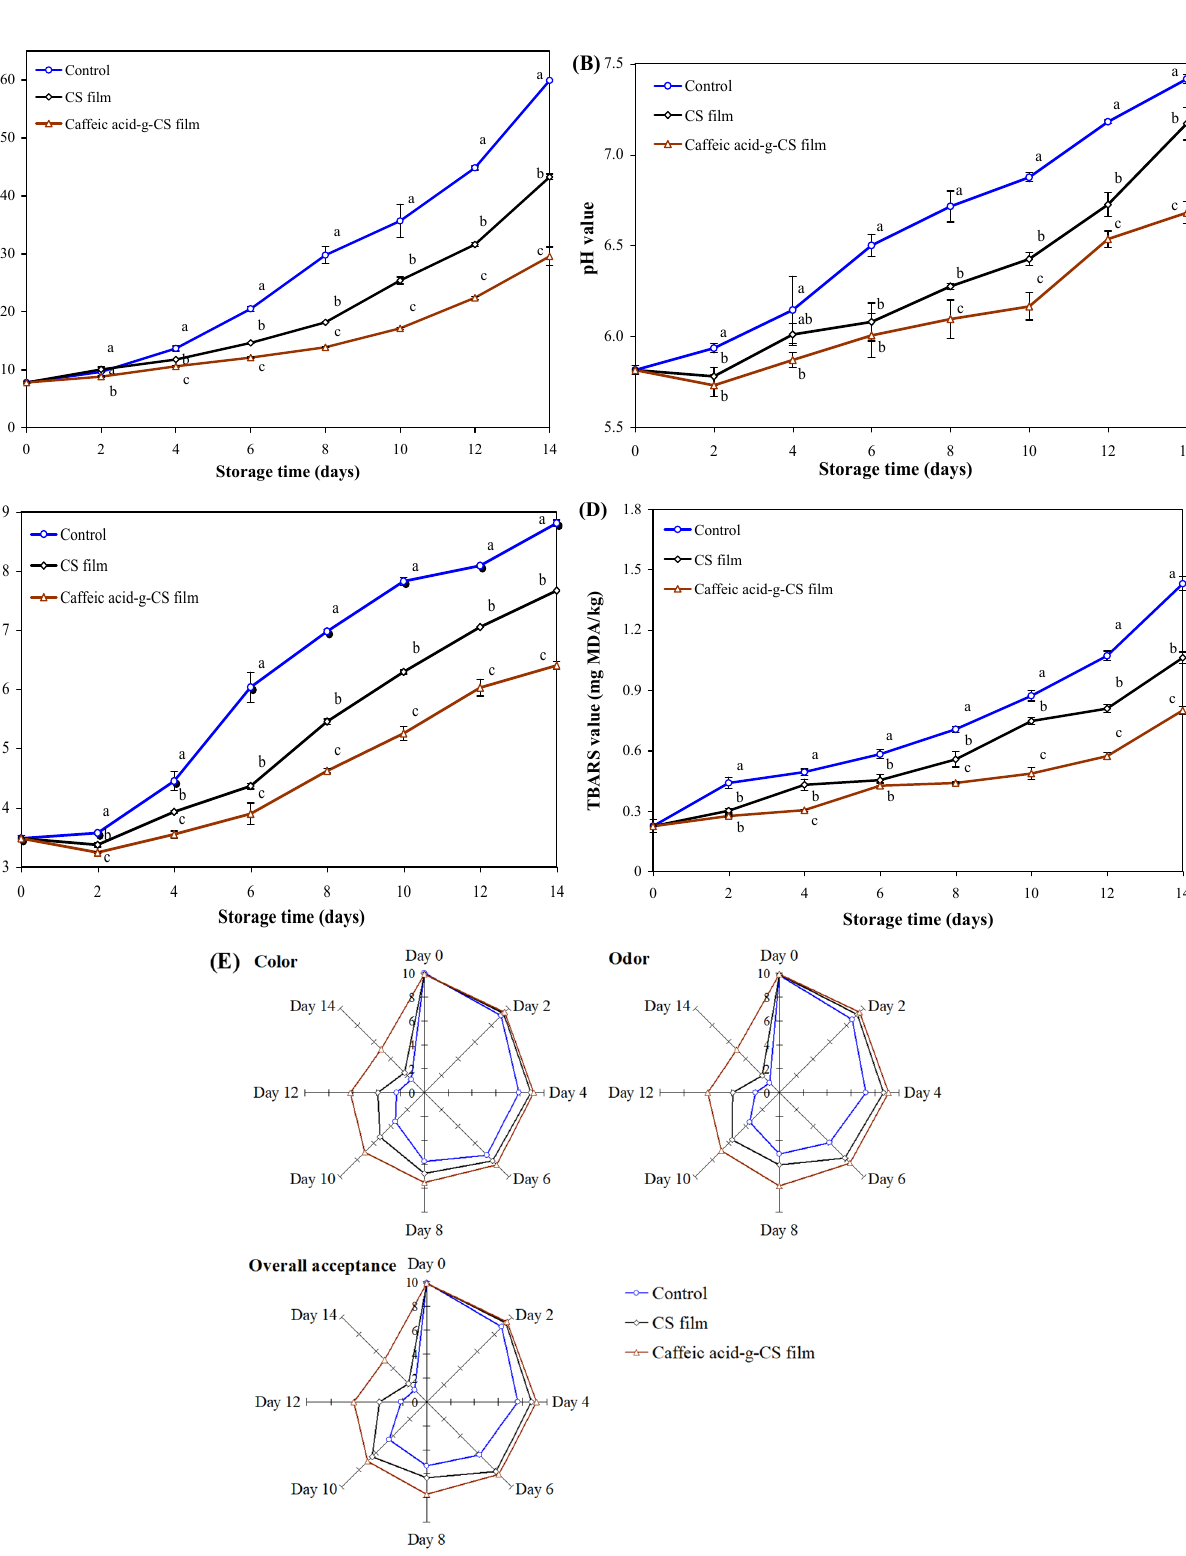
Figure 7. Changes in the total volatile basic nitrogen (TVBN) value ( A ), pH value ( B ), total viable counts (TVC) ( C ), Thiobarbituric acid reactive substances (TBARS) value ( D ) and sensory properties ( E ) of pork packaged in the control group, chitosan (CS) film and caffeic acid-g-CS film at 4 °C for 14 days. Data are presented as the mean ± SD of triplicates. Different lowercase letters indicate a statistically significant difference among treatments at the same storage time ( p < 0.05).